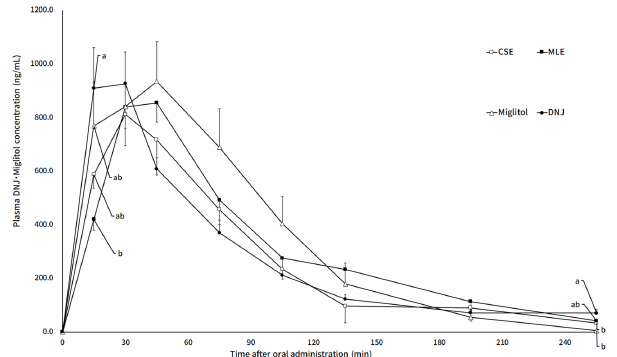
Fig 4. The transition of plasma DNJ concentration. The rats received orally administered sucrose (2 g/kg B.W.) 15 minutes after each samples administration (equivalent to 5 mg DNJ or miglitol/kg B.W.). Blood was collected from tail venous vein and plasma DNJ or miglitol concentration was determined using LC-MS/MS. Results are given as means ± SE. Means without a common letter differ significantly (p <